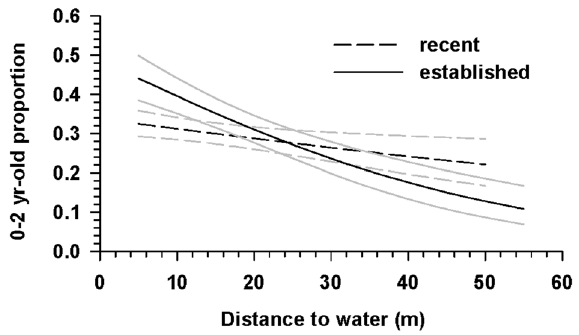
Figure 6. Proportion of 0–2-yr-olds as a function of distance to water within Pacific walrus herds hauled out onshore near Pt. Lay, Alaska. Within herd age-structure relative to distance to water for Pacific walrus herds hauled out on the northwest coast of Alaska in September 2010 and August 2011. Curves are proportion of 0–2-yr-olds for locations that have been occupied for less than a day (dashed) or more than a day (solid). The gray lines denote 95% confidence intervals.